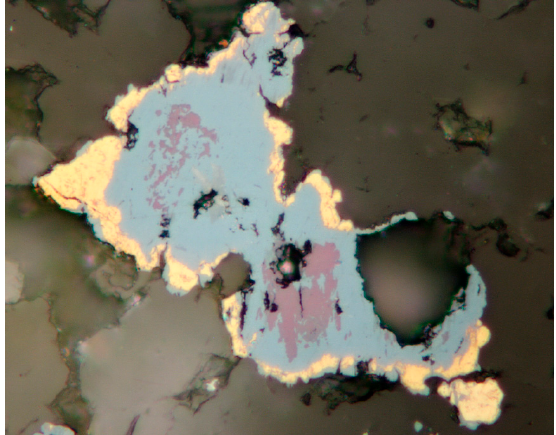
Figure 12. Earlier berzelianite (blue) with umangite (violet) inclusions replaced by later chalcopyrite (yellow). Reflected light, one polarizer. FOV 525 μ m. P ř íbram, a dump of shaft 16. Photo by P. Škácha.